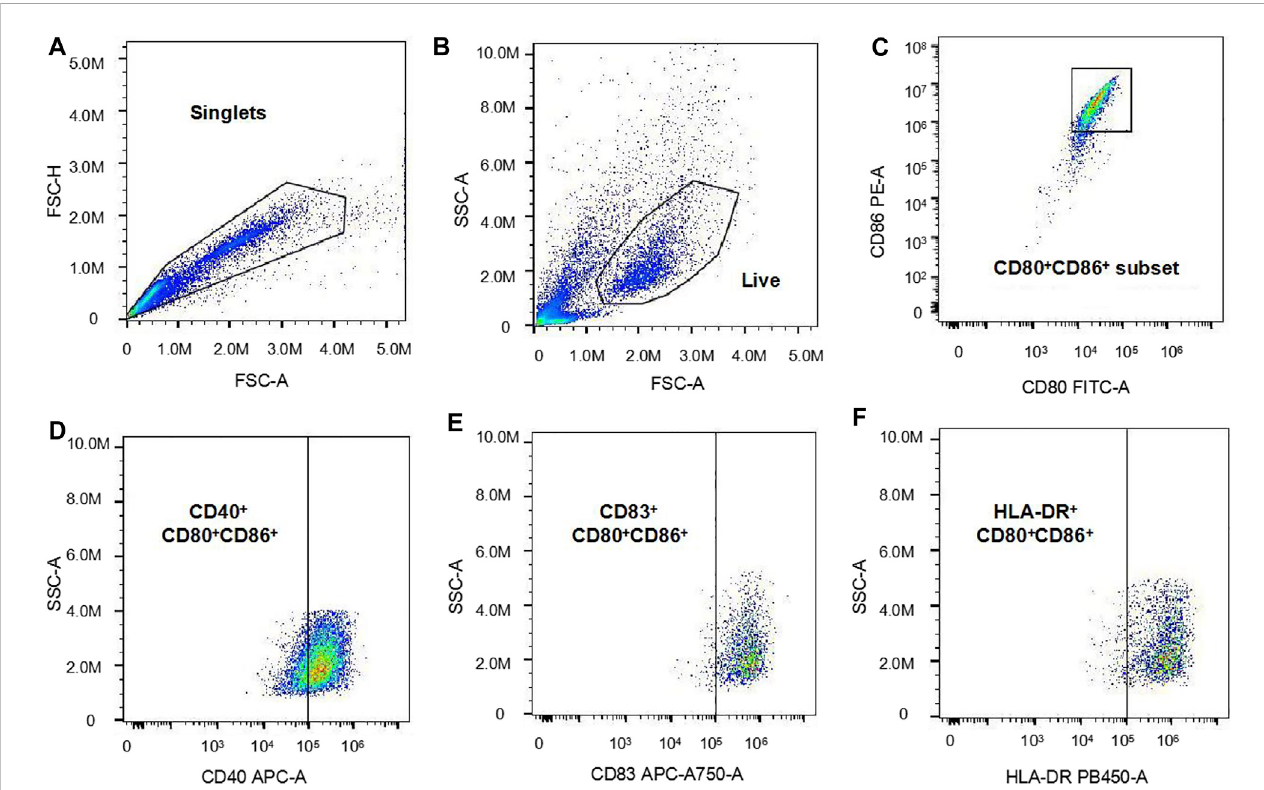
Theanalysisofthe fl owcytometrydata. (A) :Theforwardscatterarea(FSC-A)andtheforwardscatterheight(FSC-H)wereusedfortheselectionofsingle cells. (B) : The FSC-A and the side scatter area (SSC-A) were used for the selection of live cells. (C) : CD80 + CD86 + cells were selected from the live cells and de fi ned as moDCs (D – F) : The MFI of CD40, CD83 and HLA-DR expression on moDCs were analyzed